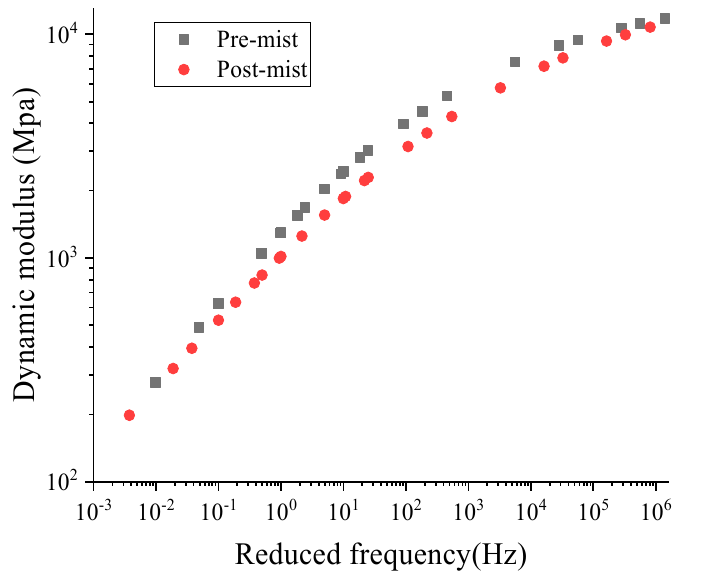
Figure 7. Master curve of dynamic modulus at 21 °C of pre-mist and post-mist CIR asphalt mixture.